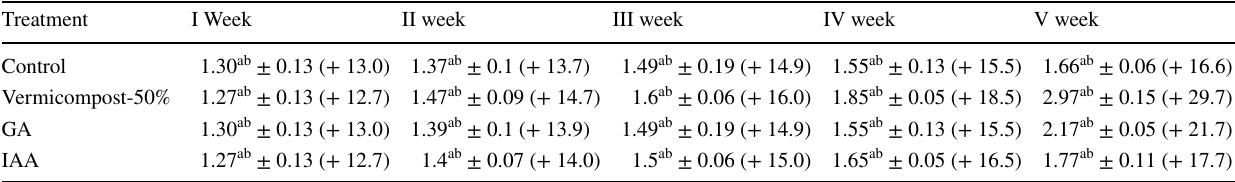
Values are mean ± S.E of 10 individual observations. Values in parentheses are percent change over control. Degrees of freedom F ≤ 0.05 a Represents significance of variance between periods b Represents significance of variance between Table 3 Effect of vermicompost and PGRs on internodal length (cms) of C. annum